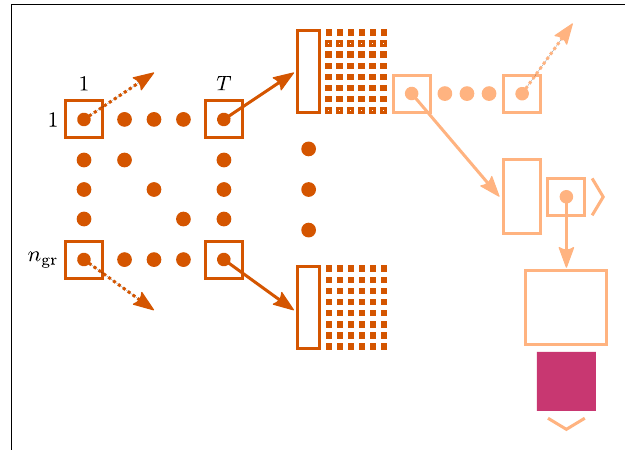
FIGURE 1 | Connection infrastructure in NEST optimized for supercomputers for the case that a simulation is run with T threads. The n gr × T matrix of dark orange squares illustrates the vector of length T which provides thread-specific access to sparse tables (Silverstein, 2005), where each sparse table maintains n gr sparse groups.Vertical dark orange rectangles and tiny squares indicate the per-group overhead of the sparse table. For simplicity, the figure shows only once the additional infrastructure which is required for each neuron with local connections (light orange).The filled pink square illustrates a locally stored connection object. Figure adapted from Kunkel et al. (2012b).